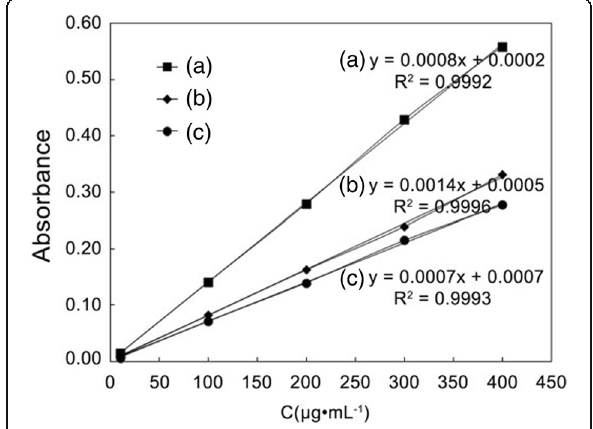
Fig. 5 Curves of UV absorbance to concentration of cis -DIDP in a deionized water, b normal saline, and c PBS